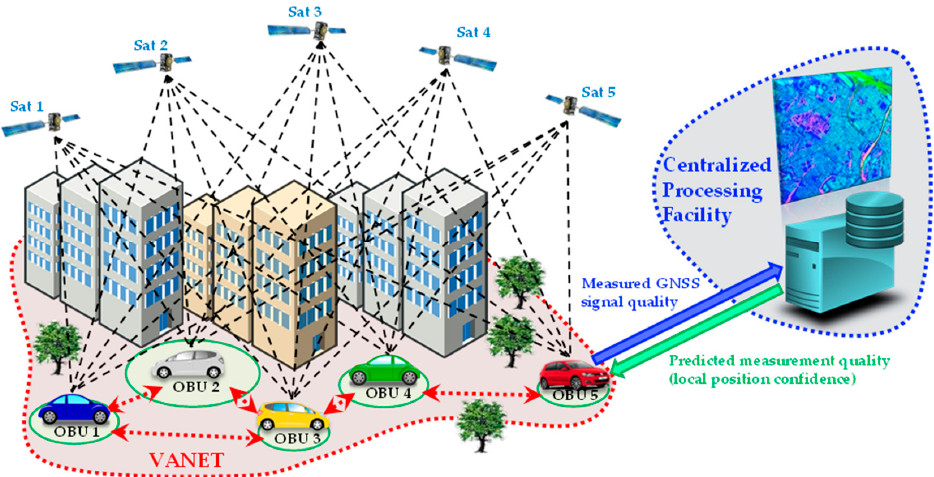
Figure 1. Illustration of the local integrity architecture: VANET communications are exploited for updating a data base with information on local GNSS measurement quality and then for predicting the local position confidence of each vehicle.